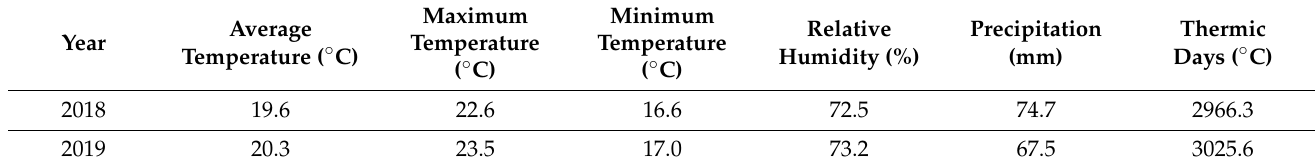
Table 10. Major climatic conditions and thermic days were observed during the production cycle of grapevine in QV, between the end of March and early September 2018 and 2019.